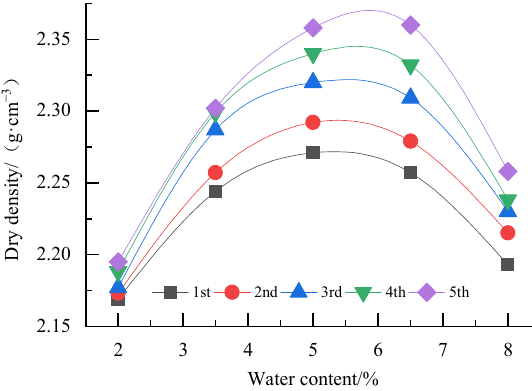
Figure 5. Test curves of repeated compaction.